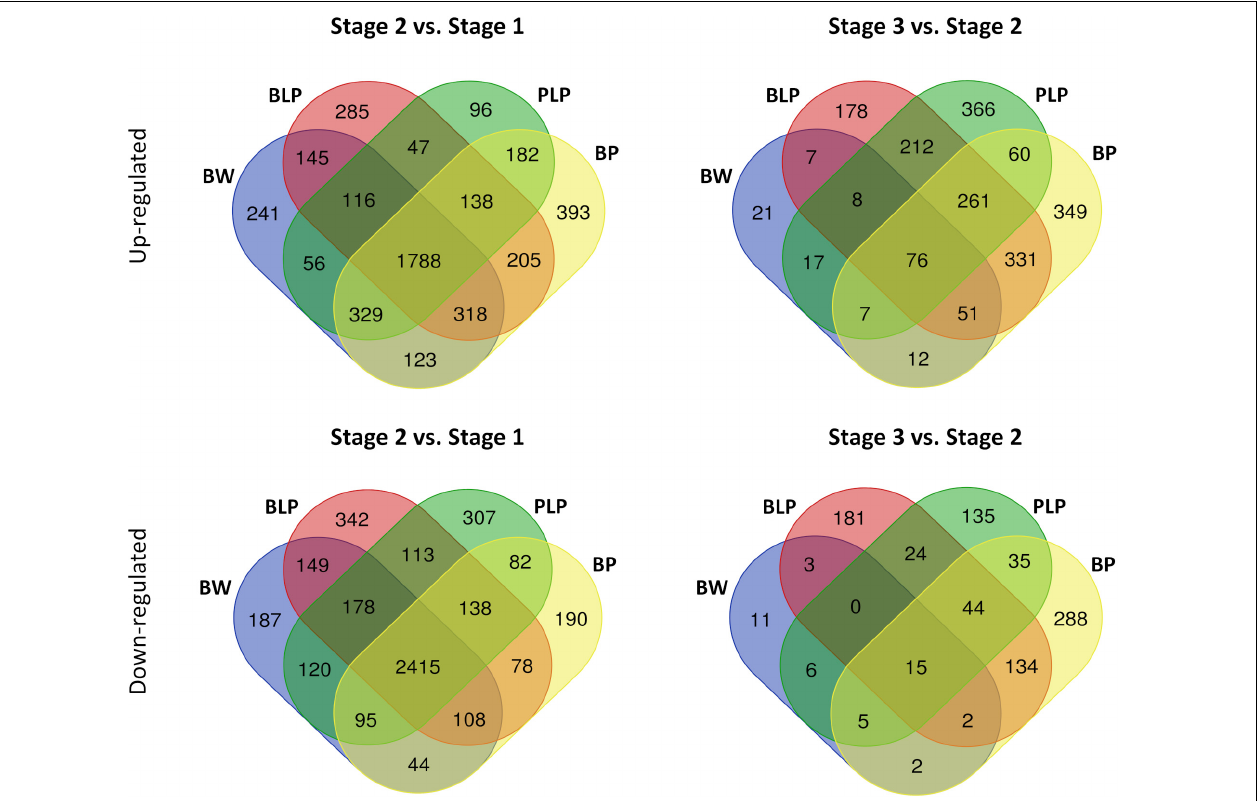
FIGURE 3 | Venn diagrams of upregulated and downregulated DEGs between stages 1 and 2 and between stages 2 and 3 within the